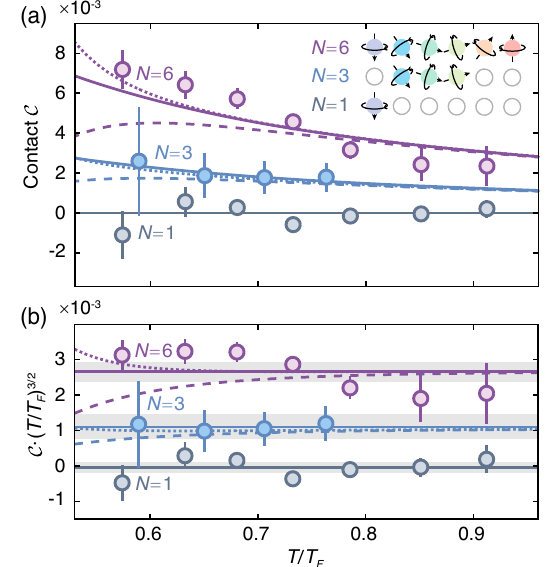
FIG. 3. Temperature scaling of contacts in SU ð N Þ fermions. (a) Contacts are measured at different temperatures in the SU ð N Þ Fermi gases. The error bars represent one standard deviation in the plateau area of S profile. The solid curves are theoretical results multiplied by a factor of 7.5. Spin configuration of different SU ð N Þ gases are presented by arrows in spheres, and the circle with nothing inside indicates the absence of the spin state. Details of spin configurations and preparation of different SU ð N Þ gases are described in the Appendix. Solid curves represent the results from the second-order virial expansion C ∝ ð T=T Þ − 3 = 2 . Dashed and dotted curves represent results F including corrections up to b 3 and b 4 , respectively. (b) Using the temperature scaling C ∝ ð T=T F Þ − 3 = 2 , contacts of SU ð N Þ gases at different temperatures are collapsed to the Fermi temperature T ¼ T F . The solid lines are means of collapsed contacts. The shaded gray area indicates the experimental uncertainty, which consists of the standard error and the standard deviation of each point. Dashed and dotted theoretical curves including high-order corrections are no longer flat. A horizontal error bar of (cid:2) 0 . 05 T=T F is not shown for every data